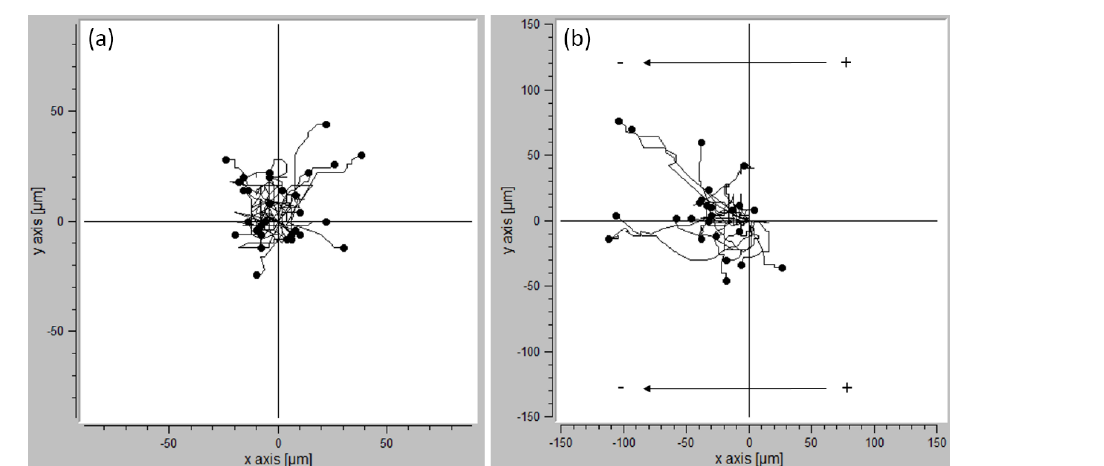
Figure 3. Directional migration of the 661W cell line for (a) control and (b) applied DC EF for cell tracks of a representative experiment (120min). The cathode and the anode are marked as − and + , respectively.